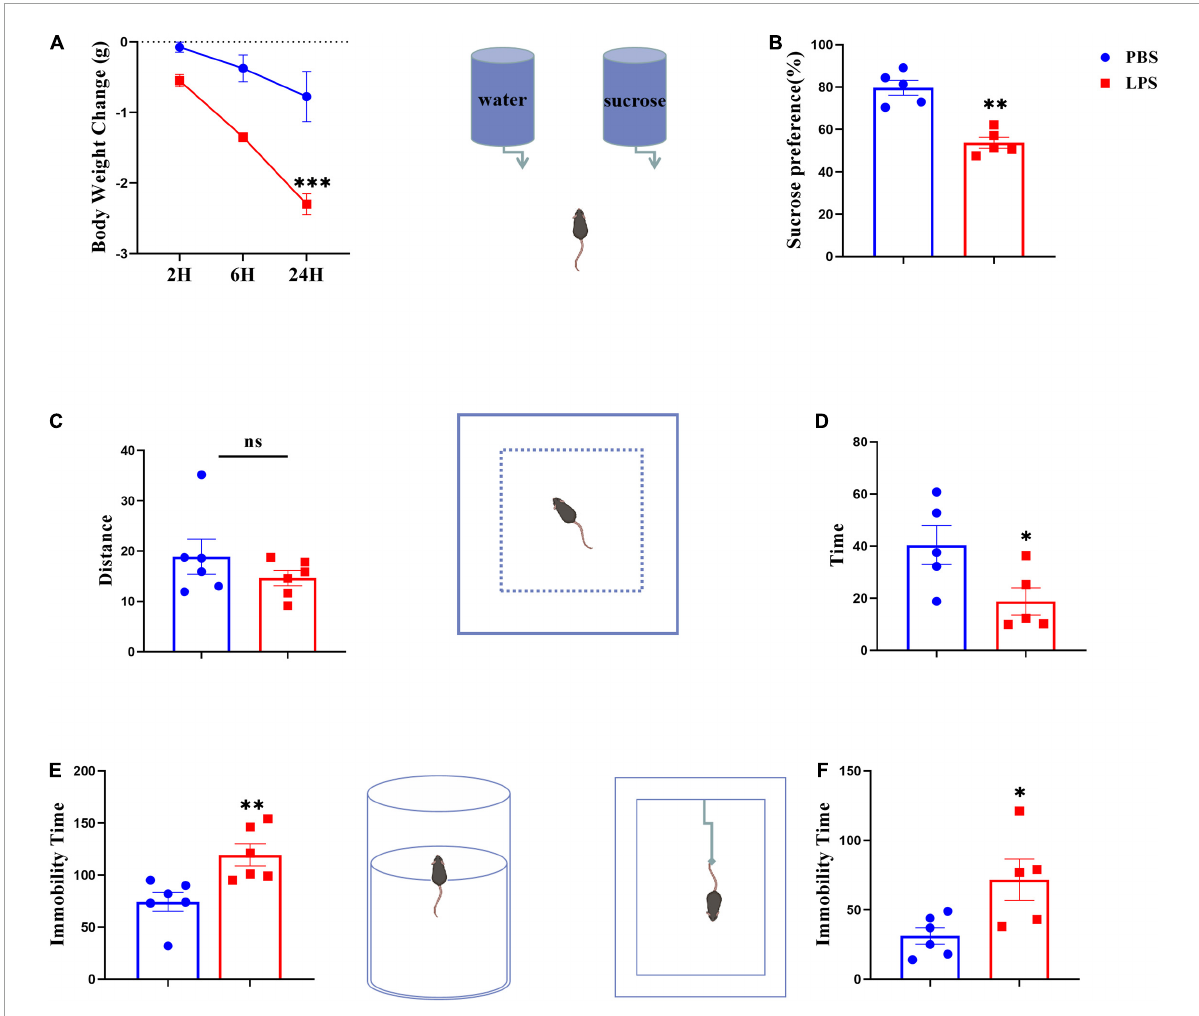
FIGURE2 Lipopolysaccharide-stressed mice exhibit depression-like behaviors. The body weight changes and sucrose preferences in LPS-stressed mice are shown in panels (A,B) . Locomotor activity was evaluated as shown in panel (C) . The depression-like behaviors were tested by the time spent in central zones in OFT (D) , and immobility time in FST (E) and TST (F) . Data were expressed as the mean ± SEM ( n = 5 per group). ∗ p < 0.05, ∗∗ p < 0.01, ∗∗∗ p < 0.001, compared with the saline group. ns , no statistical